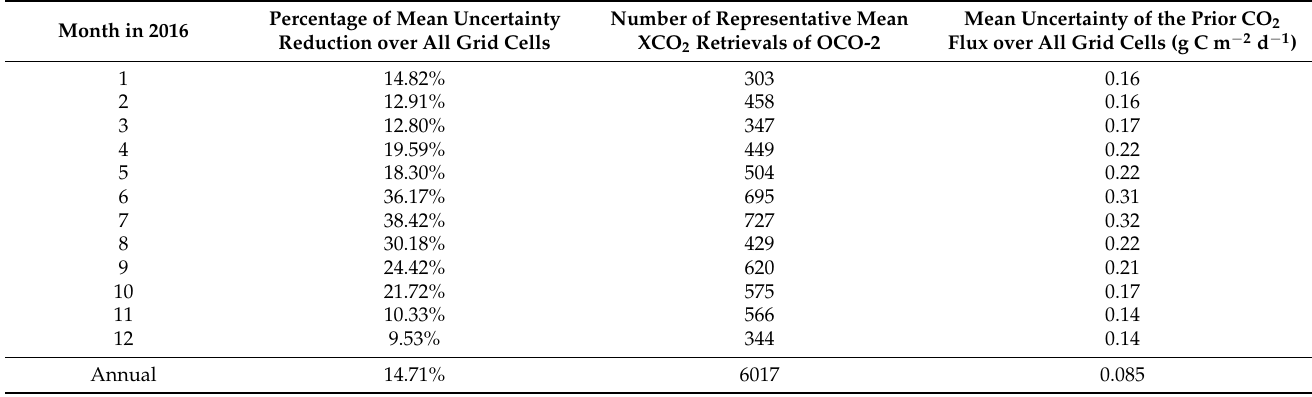
Table 3. Monthly mean uncertainty of the prior CO 2 flux, the monthly mean uncertainty reduction percentage over all grid cells and the number of the representative mean XCO 2 retrievals of OCO-2 of each month in 2016. Percentage of Mean Uncertainty Month in 2016 Reduction over All Grid